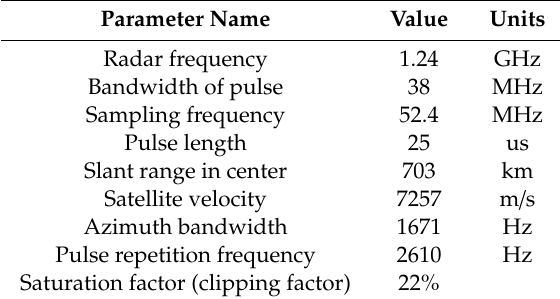
Table 5. Echo simulation parameters of ALOS-2.